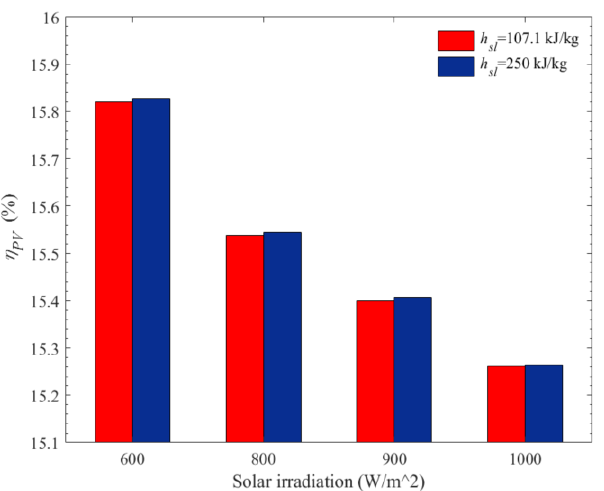
Figure 3. Effect of solar irradiation and latent heat on the PV temperature at c = 2%, ṁ = 0.045 kg/s, N = 8, and H = 30 mm. N = 8, and H = 30